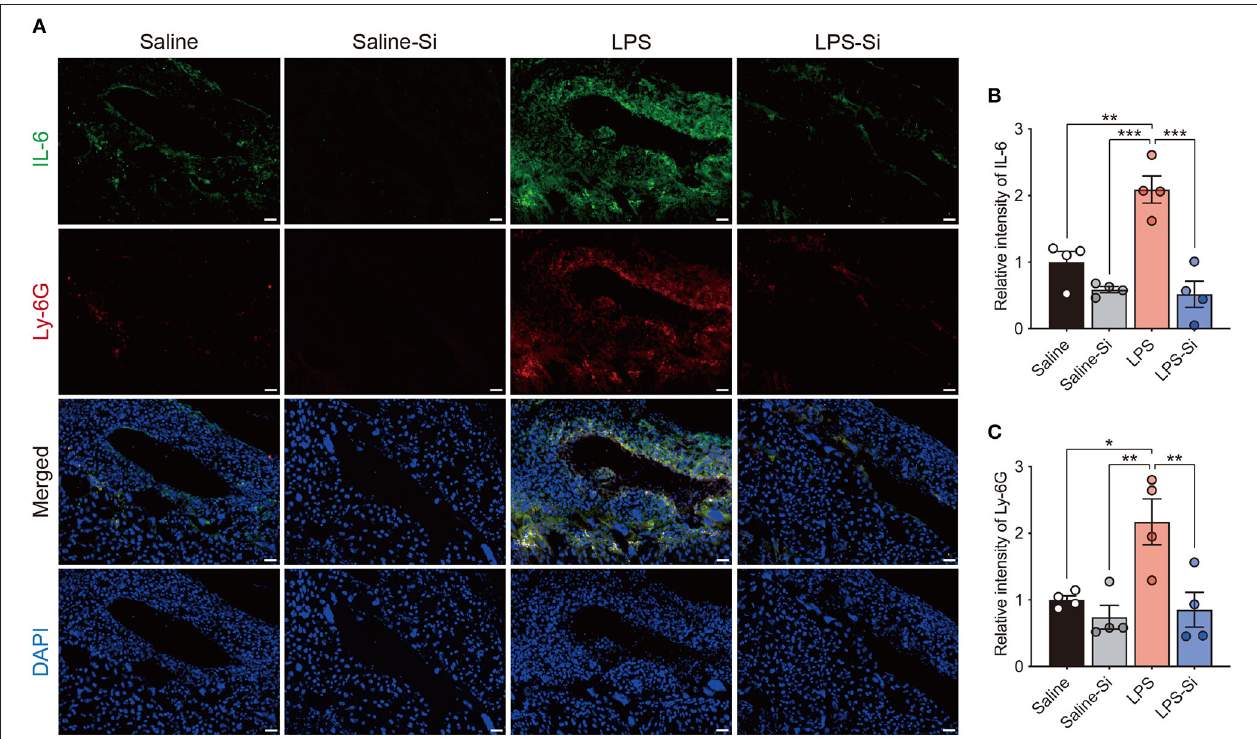
FIGURE 3 | Anti-inflammatory effect of the Si-based agent in the placenta. (A) Fluorescent images of IL-6 and Ly-6G staining in the central region of mouse placenta at 4h after the second administration. (B,C) Quantifications of relative intensities of IL-6 (B) and Ly-6G staining (C) . Placental inflammation and peripheral neutrophil aggregation induced by LPS were suppressed by the Si-based agent. IL-6 : interleukin-6, a marker of inflammation , Ly-6G: a marker of peripheral neutrophils. Data are presented as means ( ± SEM). *** P < 0.001, ** P < 0.01, * P < 0.05, one-way ANOVA. n = 4/condition. Scale bars: 50 µ